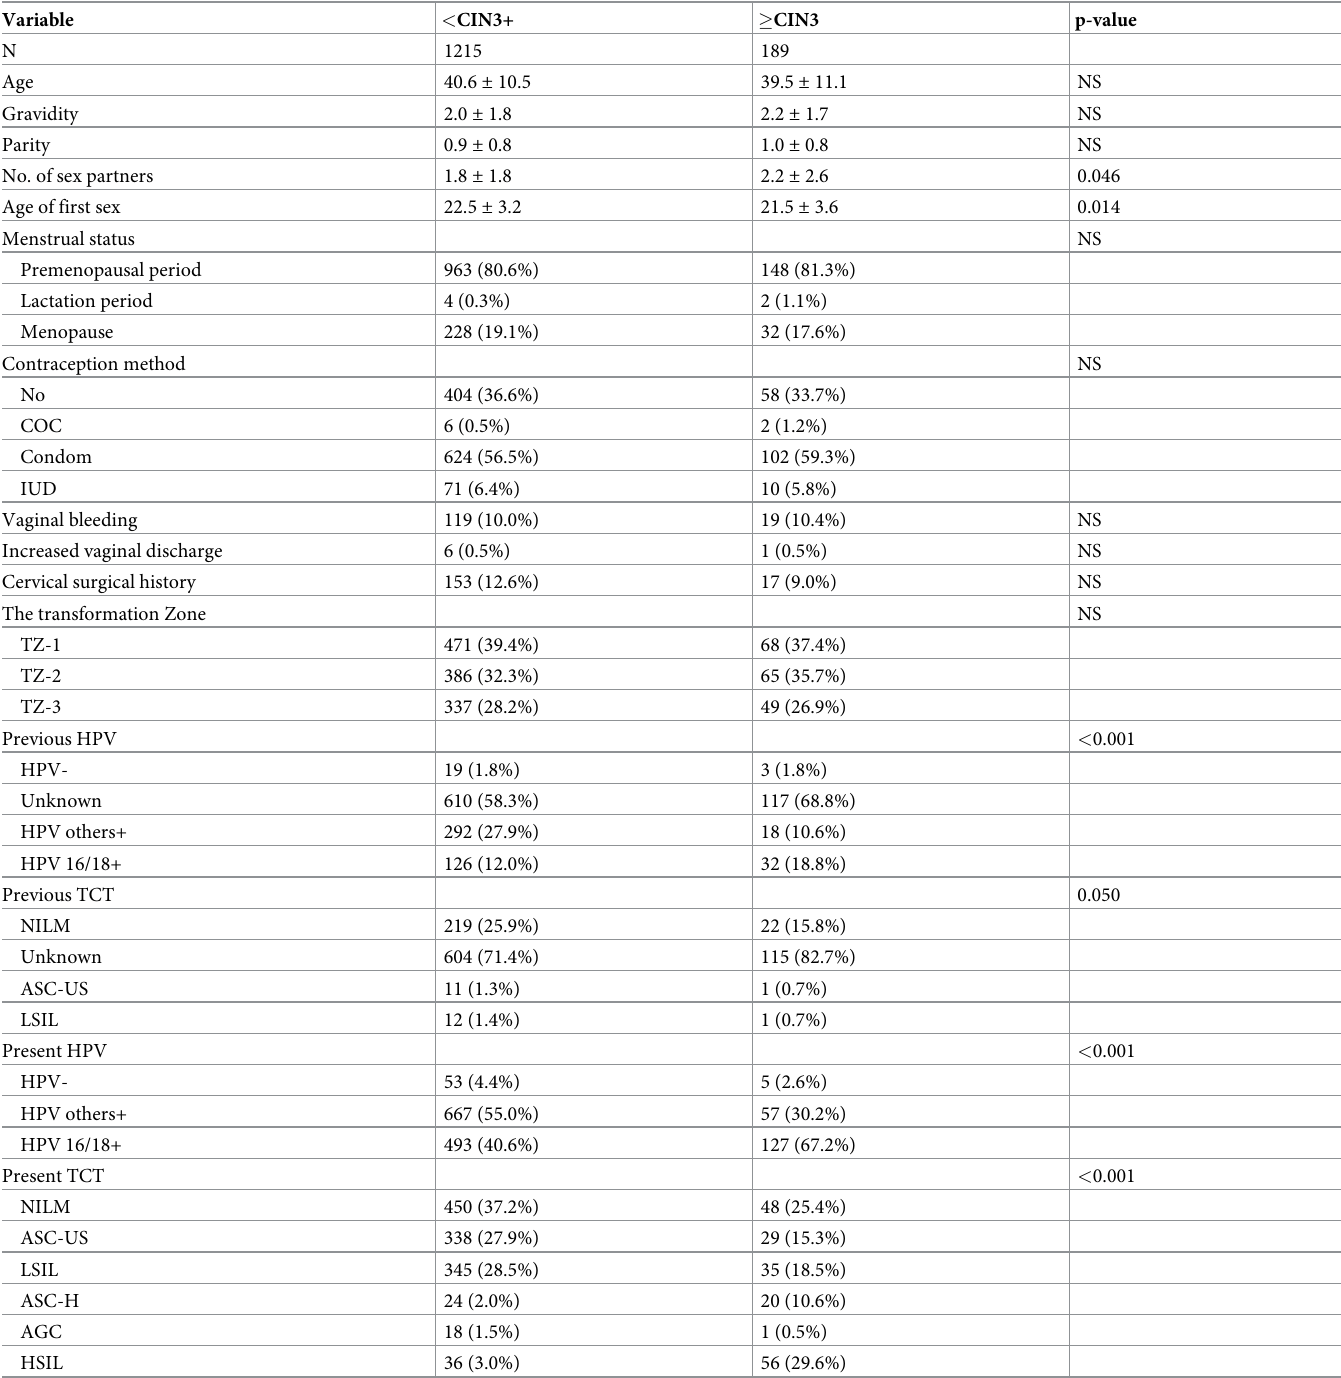
Table 1. Basic characteristics of